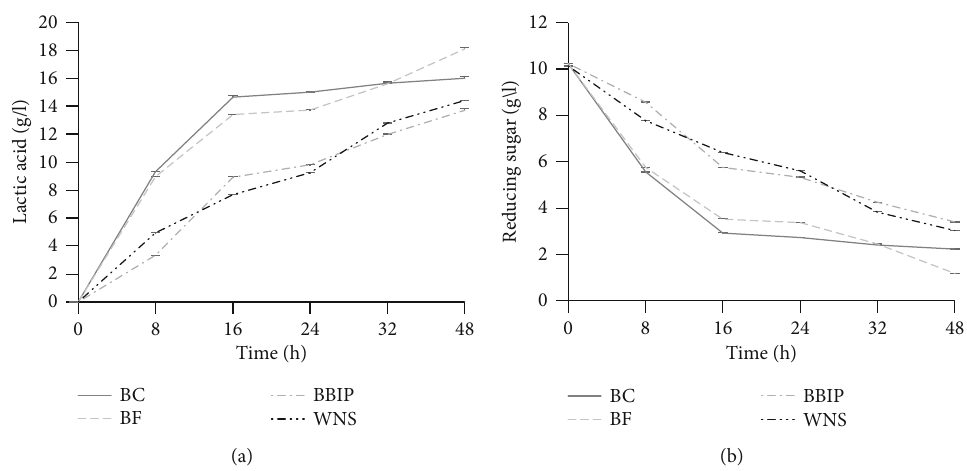
Figure 1: Kinetics of LA production (a) and reducing sugars consumption (b) in di ff erent production medium. BC: production medium containing by-products from chicken as nitrogen source; BIPB: production medium containing by-products of the beer production industry as nitrogen source; WNS: production medium without a nitrogen source; BF: production medium containing by-products from fi sh as nitrogen source. Table 4: Lactic acid, volumetric productivity, and lactic acid yield after 16 h of fermentation.